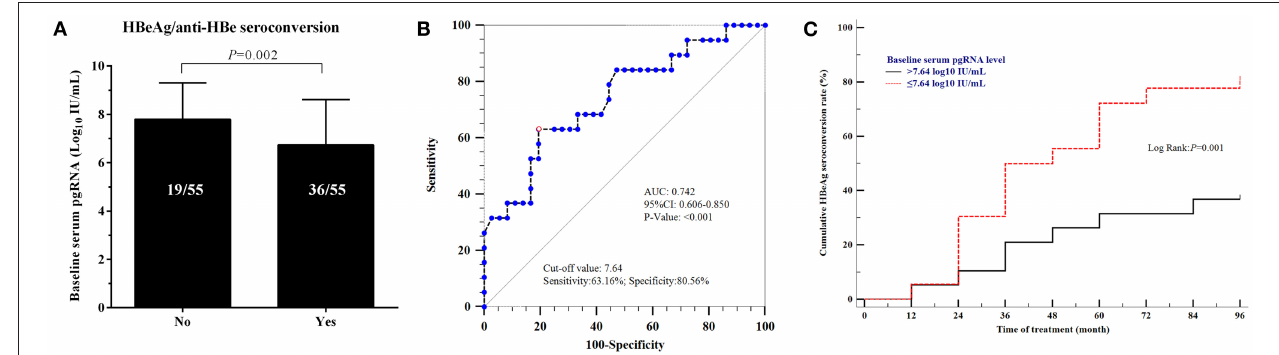
FIGURE 5 | Relationships between HBeAg seroconversion and baseline serum pgRNA levels. (A) Comparison of the levels of baseline serum pgRNA in patients with/without HBeAg seroconversion. Data were compared using t- test. (B) Predictive value of baseline serum pgRNA for HBeAg seroconversion using ROC curve analysis. (C) Cumulative rate of HBeAg seroconversion in patients with baseline serum pgRNA > 7.64 log10 IU/mL and ≤ 7.64 log10